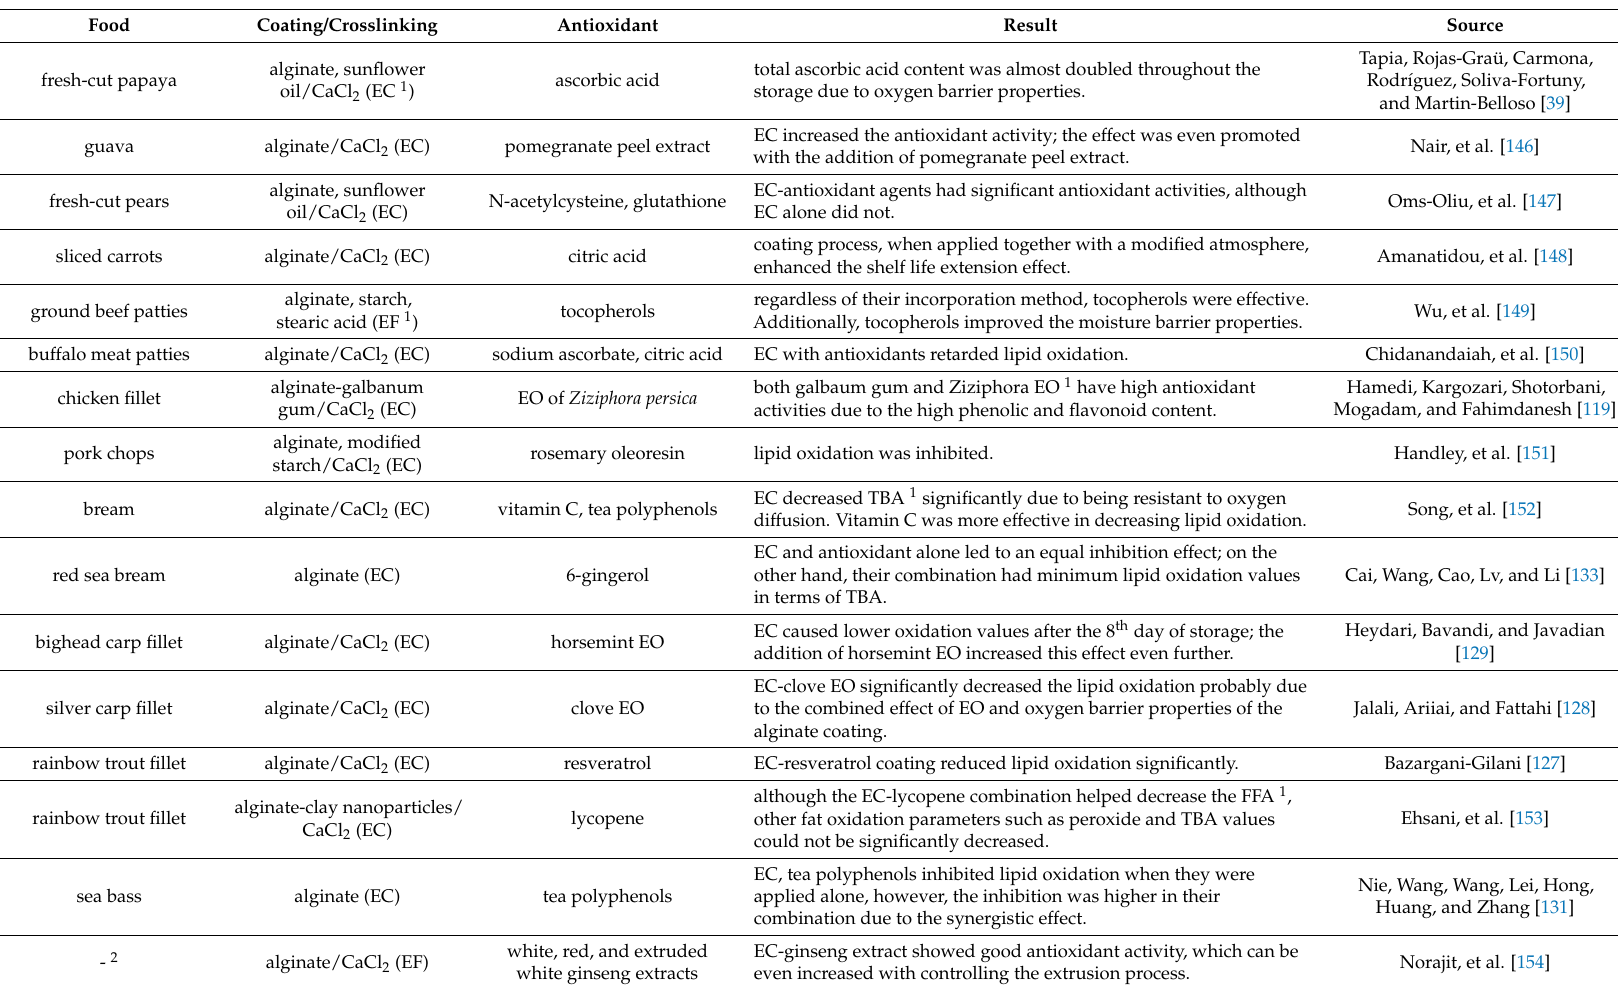
Table 2. The incorporation of antioxidant agents in alginate-based edible films and